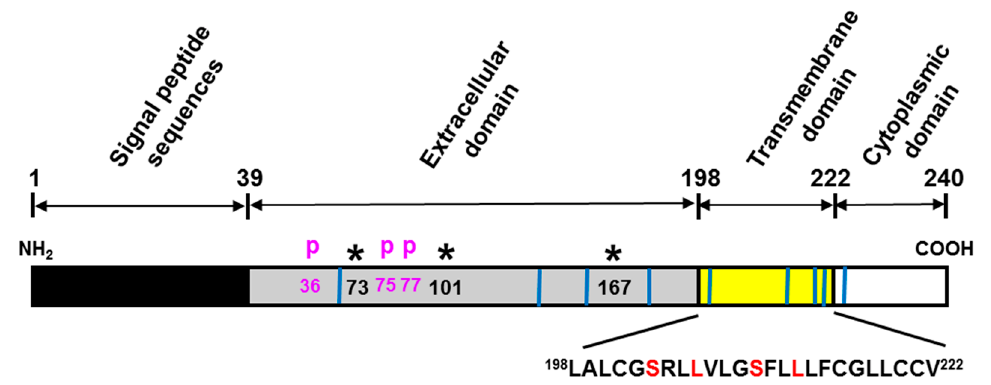
Figure 2. Structure of human IGFBP-3R (TMEM219). The 202-residue mature IGFBP-3R, omitting the 38-residue signal peptide, is comprised of three domains: extracellular, transmembrane, and cytoplasmic domains. Extracellular domain contains three potential N -glycosylation sites (residues 73, 101, 167) and three potential phosphorylation sites (S36, T75, T77). The single-span transmembrane domain contains a leucine zipper-like heptad repeat pattern characteristic of leucine zipper interaction domains. The letters in red correspond to a-type and d-type interfacial residues in leucine zipper interaction domains [15]. The vertical blue lines represent nine cysteine residues.